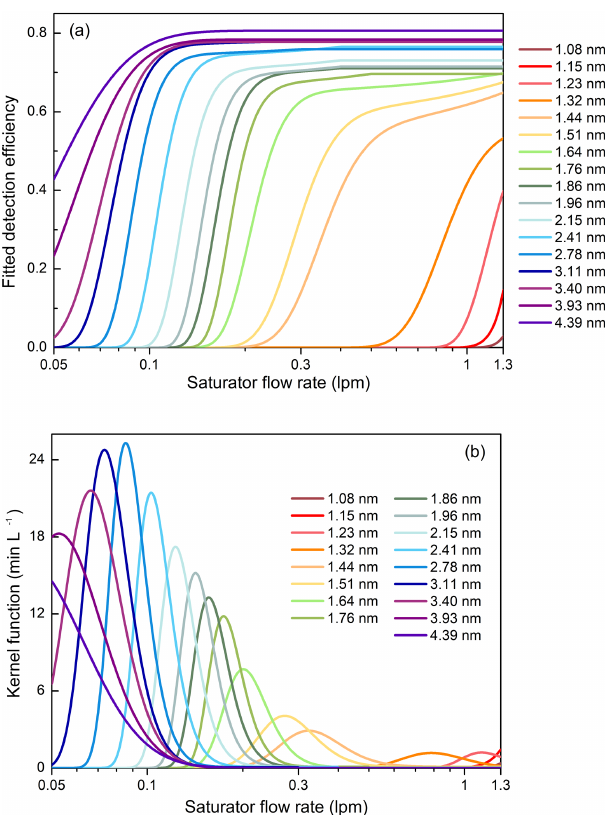
Figure 1. (a) The fitted detection efficiency curves according to cal- ibration data. (b) The estimated kernel function curves according to the fitted detection efficiencies. The kernel function is equal to the derivative of the detection efficiency with the respect to the saturator flow